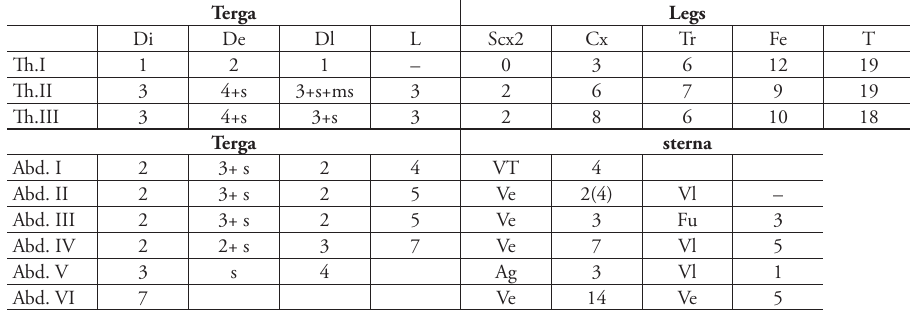
Table 1b. Body tubercles and chaetotaxy of Lobellina fusa sp. n. Terga